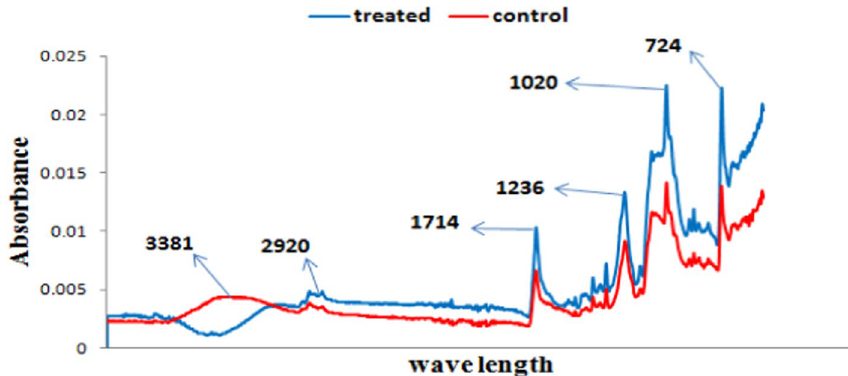
Fig. 5 FTIR Spectra of esteri- fied cotton fabric